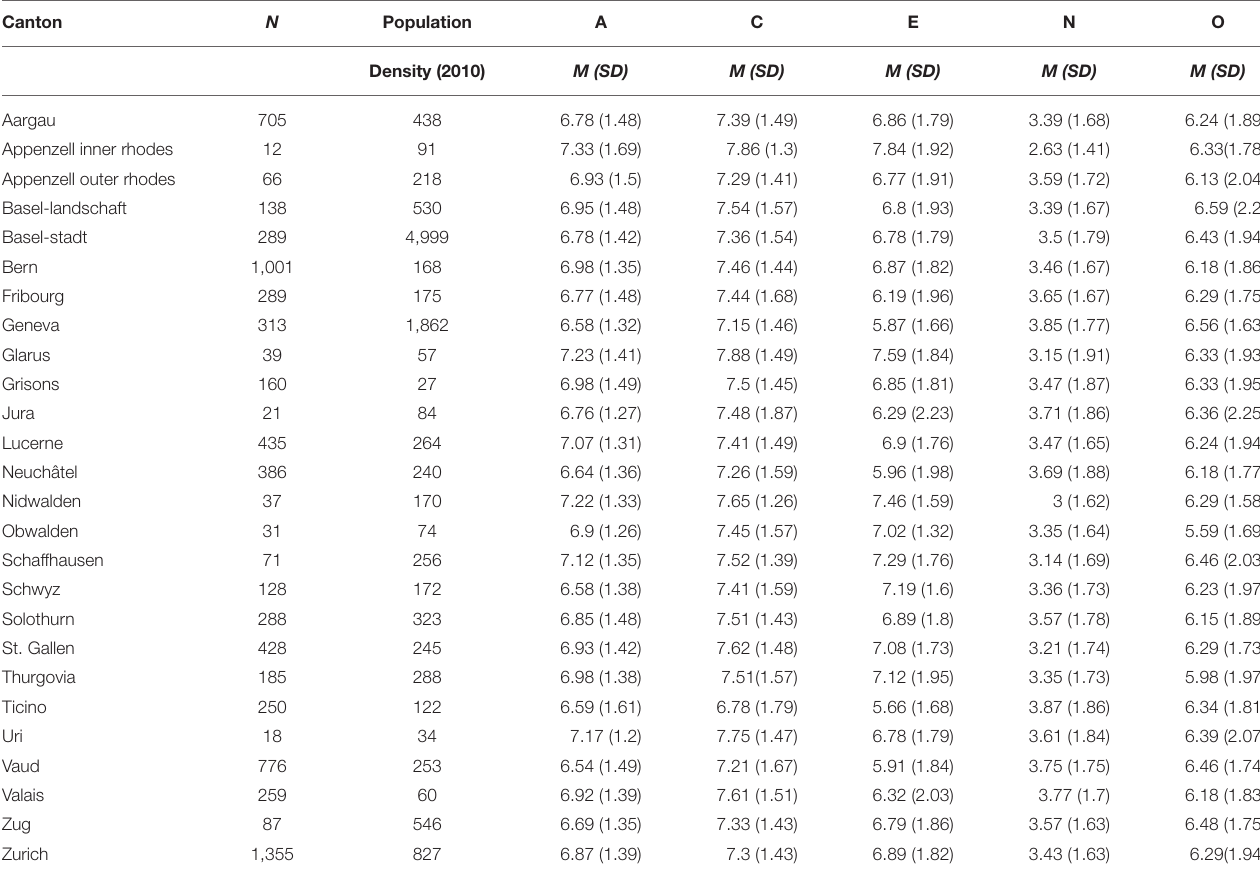
TABLE 1 | Descriptive statistics: cantonal population density and mean big five scores.